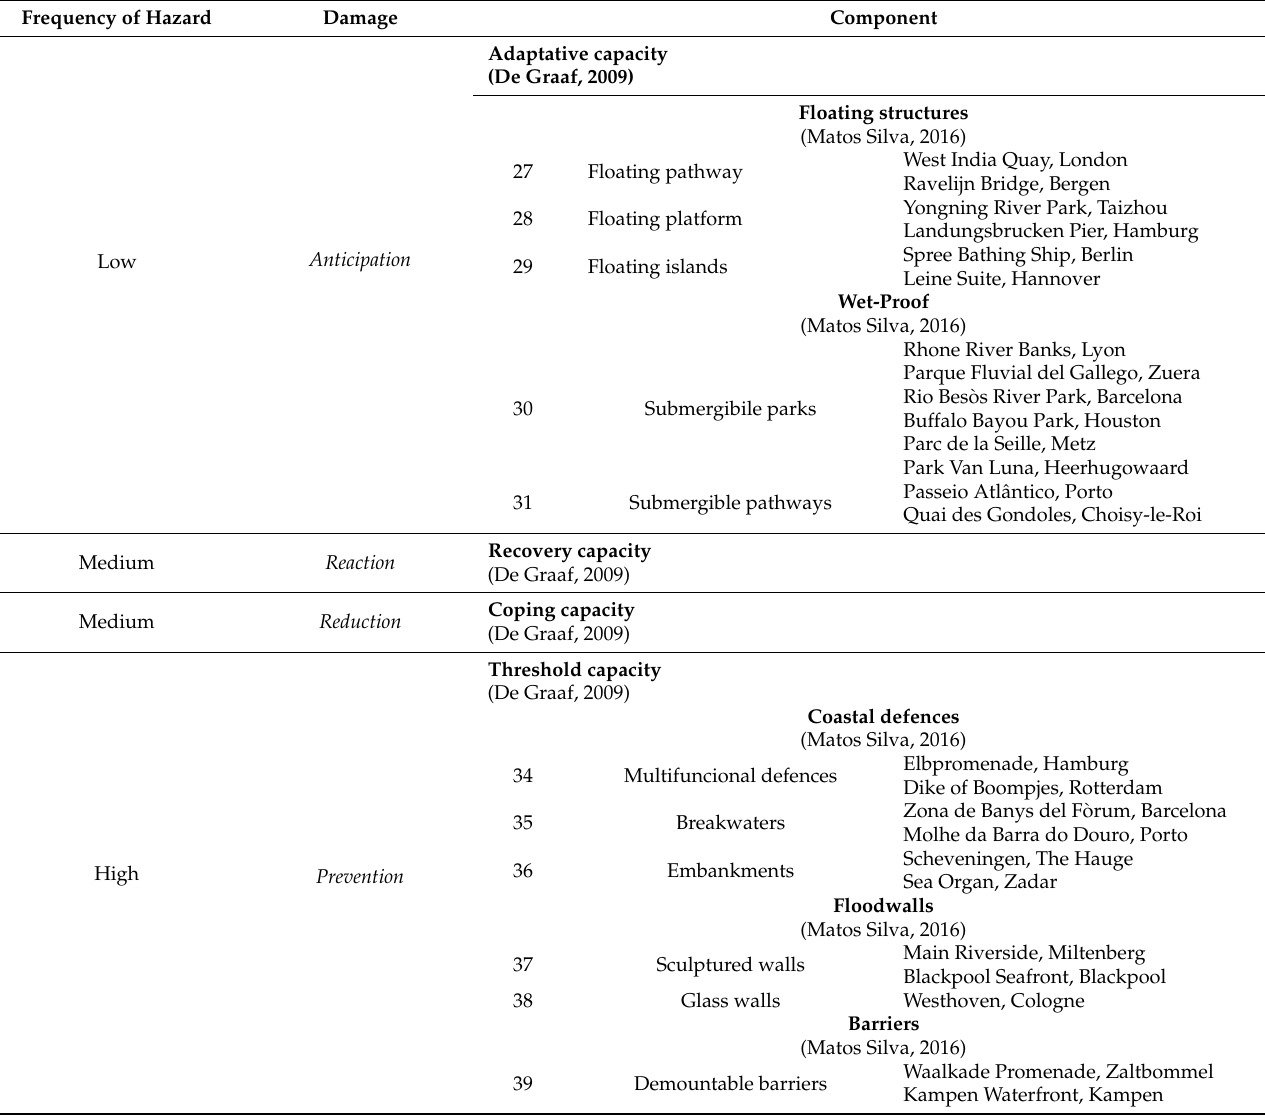
Table 1. Identification of flood adaptation categories in the vulnerability framework, combined with existing examples. Authors’s edition. Source Data: [43]:410. [39]: